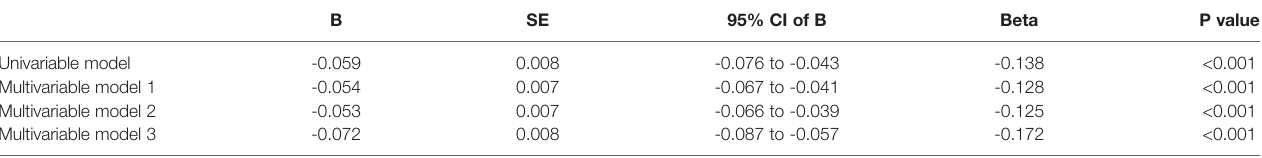
TABLE 3 | Linear regression analysis of FSH levels and eGFR levels in post-menopausal women.